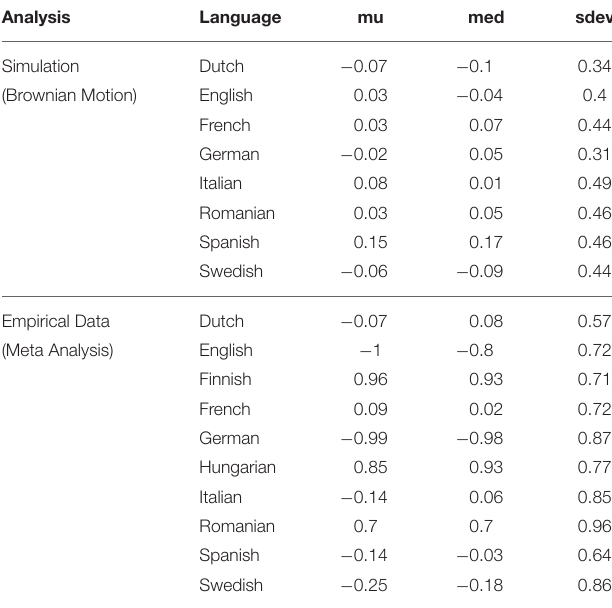
TABLE 1 | Descriptive statistics of pseudo-complexity and empirical complexity